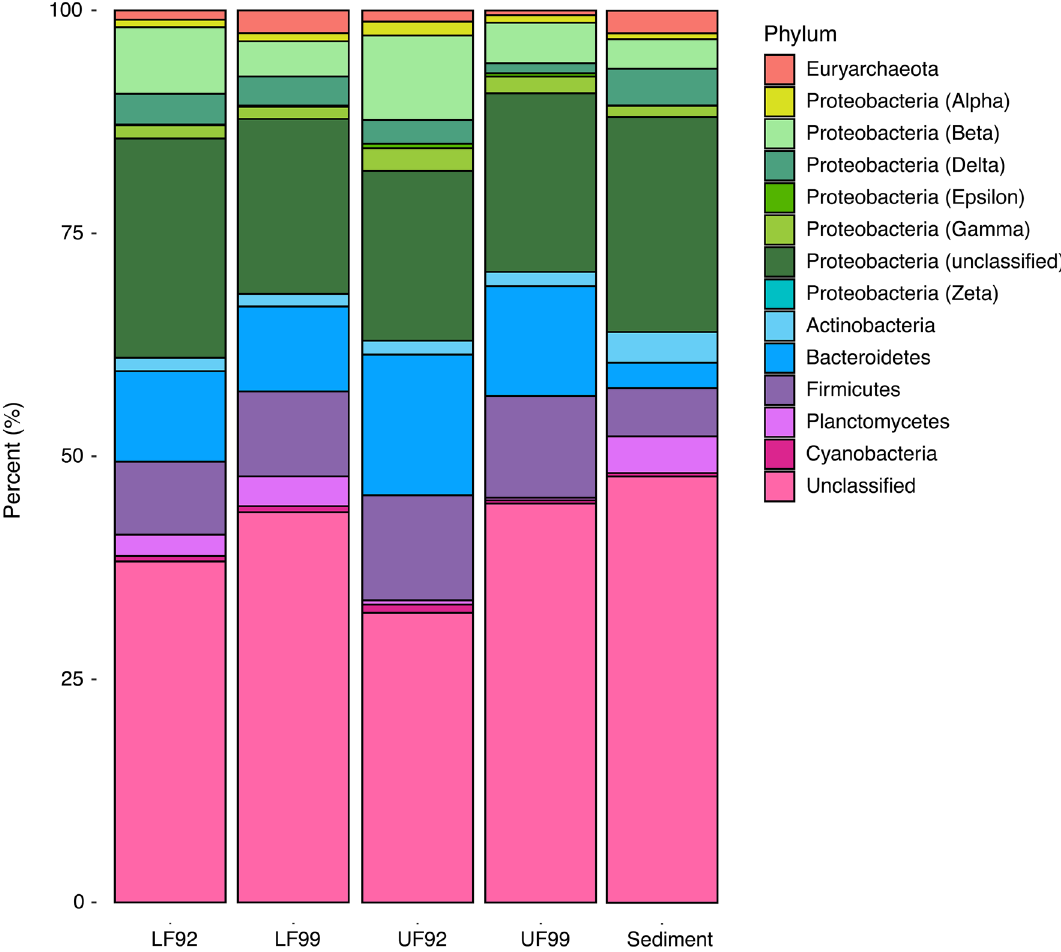
Figure 3. The taxonomic composition of the communities at the phyla level. Classified organisms in the figure only include phyla that make up more than 1% of the are Clostridia and Bacili. A summary can be found in Table 2 and more detail is included in the Supplementary Information. Taxonomic differences between fraction sizes. To ascertain if cell size played a role in survival capa- bilities in this extreme environment, we assessed the metabolic potential within the size fractions. While the percentage of Proteobacteria in the community is more related to depth than filter size in the water column, within the Proteobacteria, we found the large fraction samples had 13–16% of the community classified as Del- taproteobacteria. In contrast, only 9% belong to ultrafine fractions. At 15%, the fraction of Deltaproteobacteria in the sediment is similar to that of the LF samples. Planctomycetes make up 2–3% of the LF samples, while they make up only 0.3–0.5% of the UF communities. Planctomycetes make up 4% of the community within the sedi- ment. More details on these differences can be found in Table 2. The size of the organisms did not seem to affect survival.